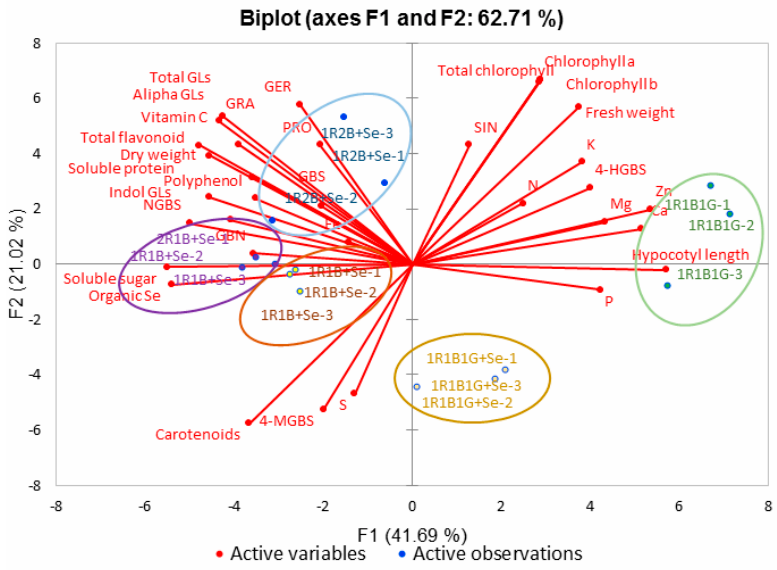
Figure 5. Principal component analysis of broccoli sprouts grown under a combination of selenium and LED light quality treatments. and LED light quality